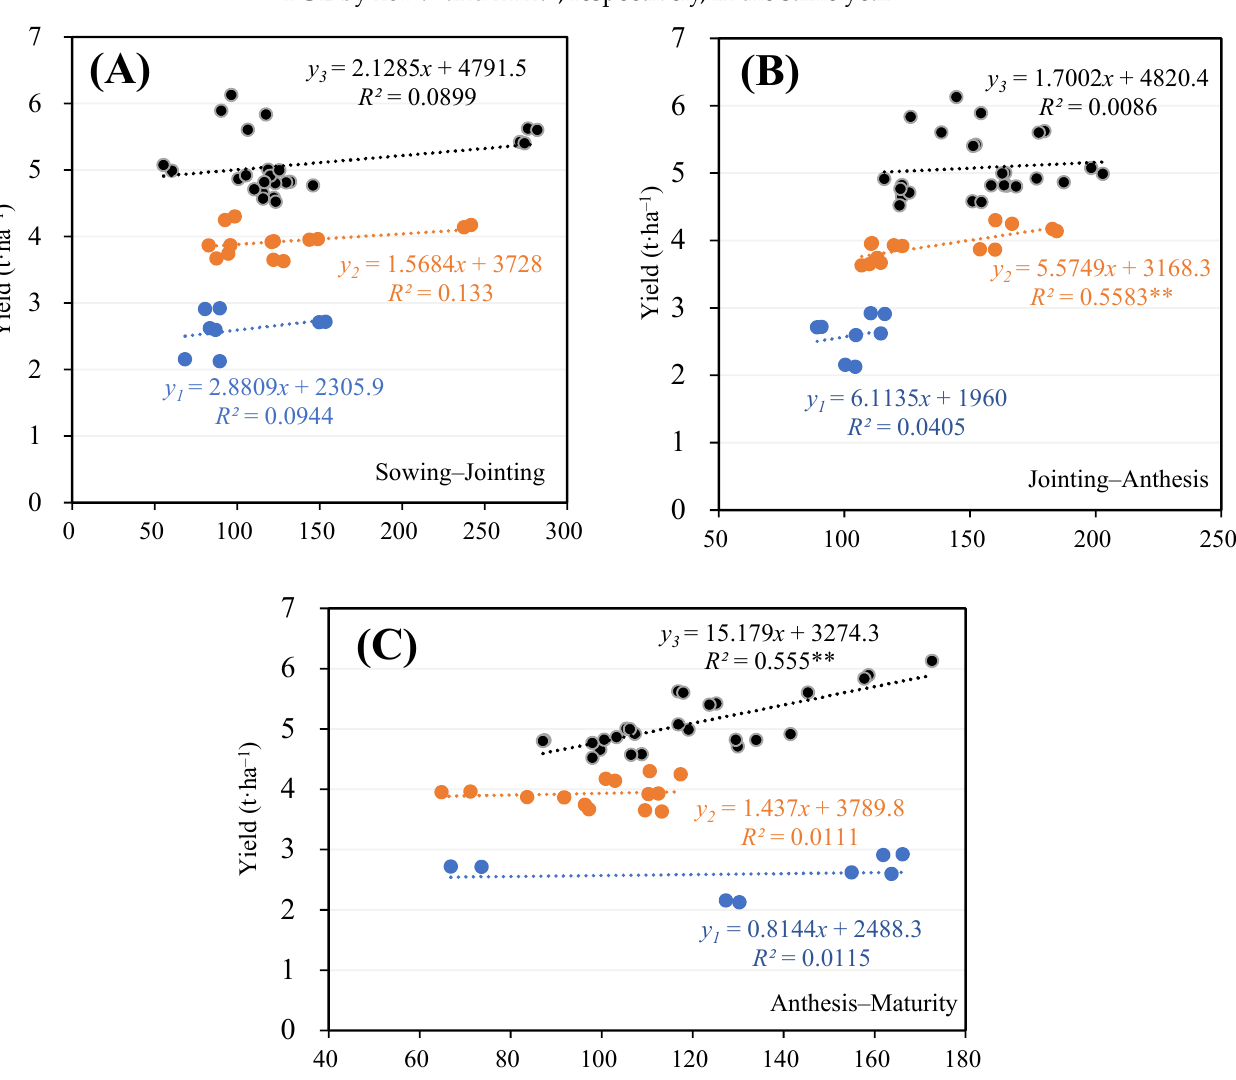
Figure 5. Correspondence between field water intake at different growth stages and yield using different sowing methods ( y 1 = DS, drill sowing; y 2 = FS, furrow sowing; y 3 = WS, wide-space sowing); ( A ) Jointing stage soil water storage, ( B ) Jointing stage- anthesis stages soil water storage, ( C ) Anthesis stages-maturity stages soil water storage; * and ** indicate differences at the 0.05 and 0.01 possibility levels, respectively.